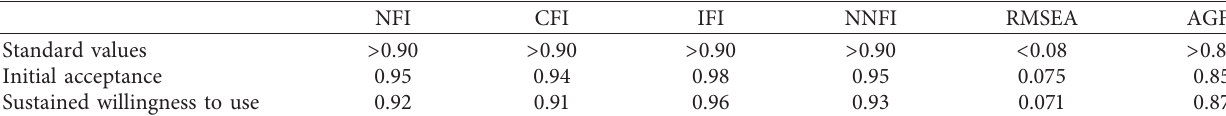
Table 6: Participation in model fitting indices.